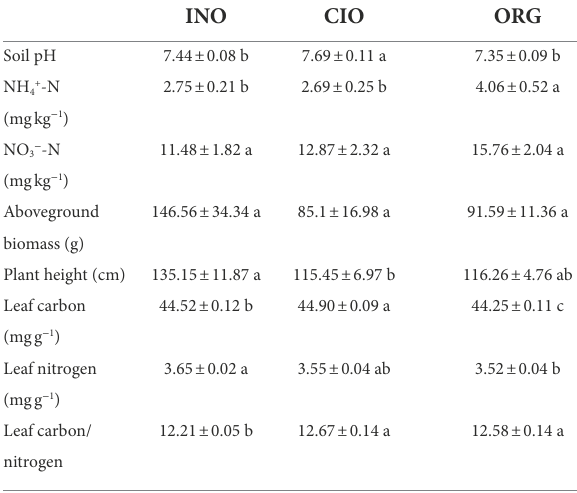
TABLE 1 Soil abiotic properties and plant traits under three different N